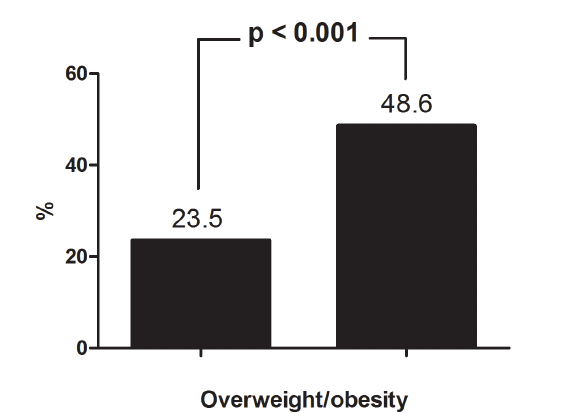
Figure 1. Incidence of overweight/obesity at 4-year follow-up.